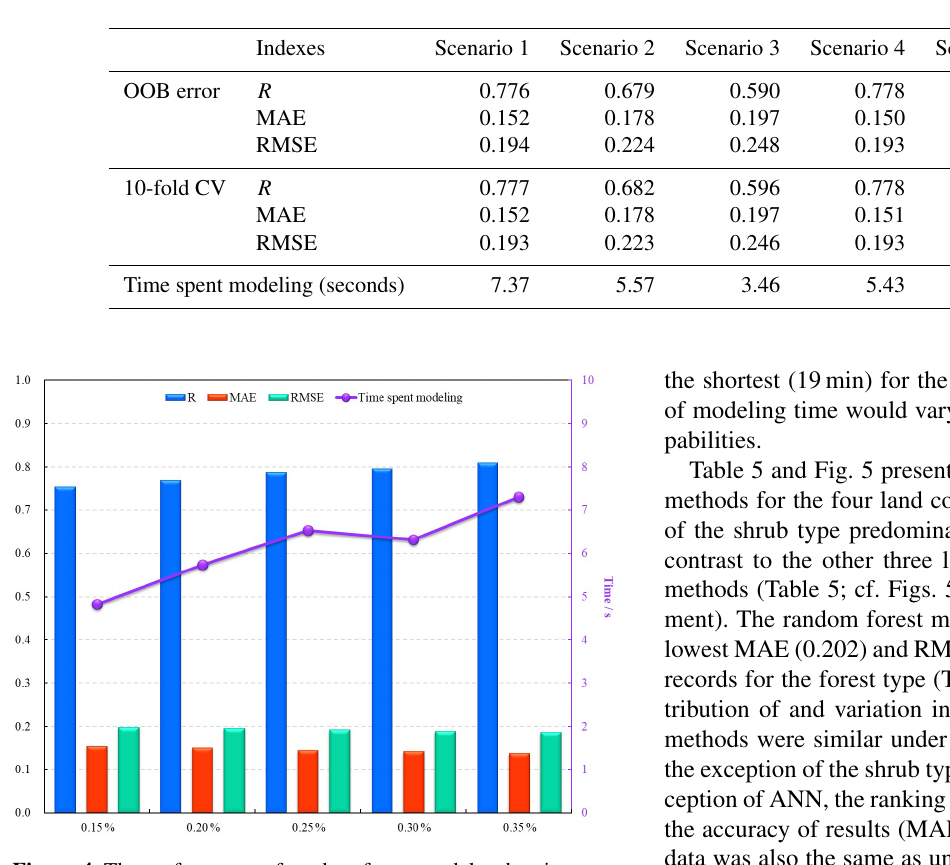
Table 4. Variable selection tests in six scenarios on bare-land-type data for the random forest method. The accuracy indexes of the estimation are calculated using OOB error estimates and 10-fold cross-validation (CV).